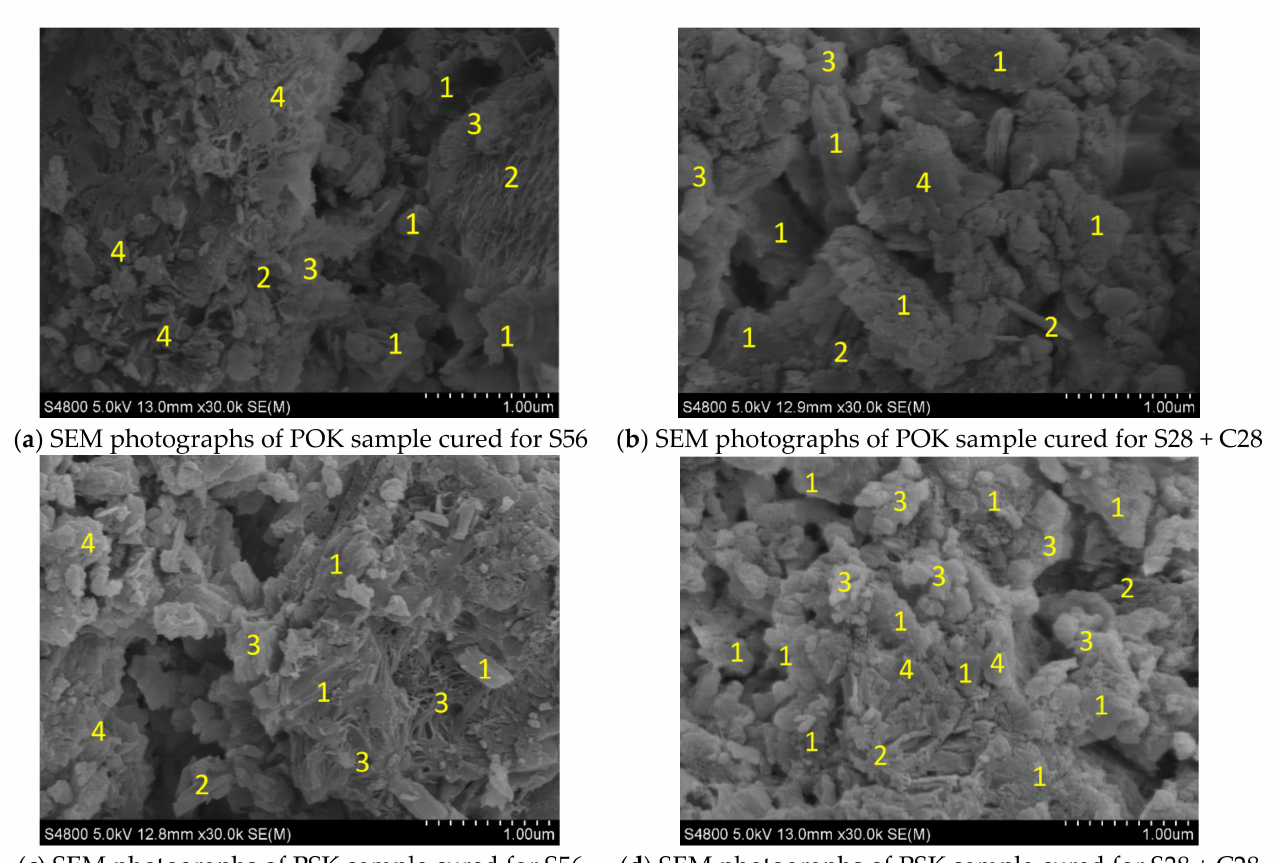
Figure 6. SEM photographs of samples. The numbers in the figures denote: 1. Calcium carbonate (CaCO 3 ). 2. Ettringite (AFt). 3. Hydrogenated calcium silicate (C-S-H). 4. Calcium hydroxide